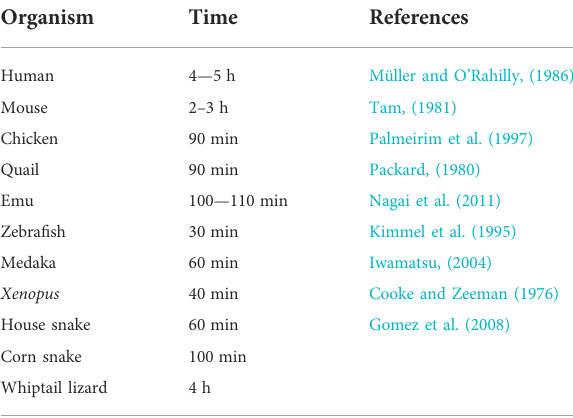
TABLE 1 Time of somite formation in different vertebrate